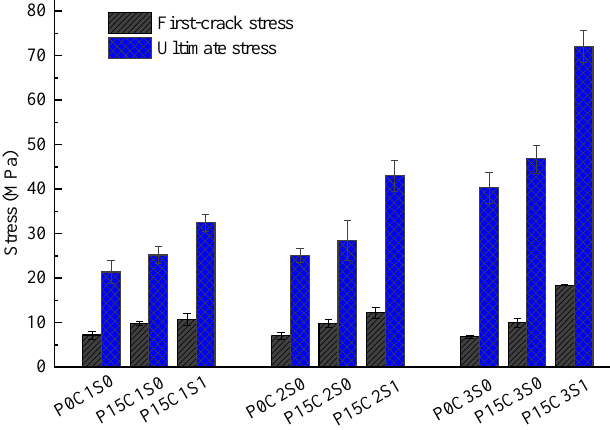
Figure 20. First-crack and ultimate stresses of the TRC specimens with prestress and steel fibres.